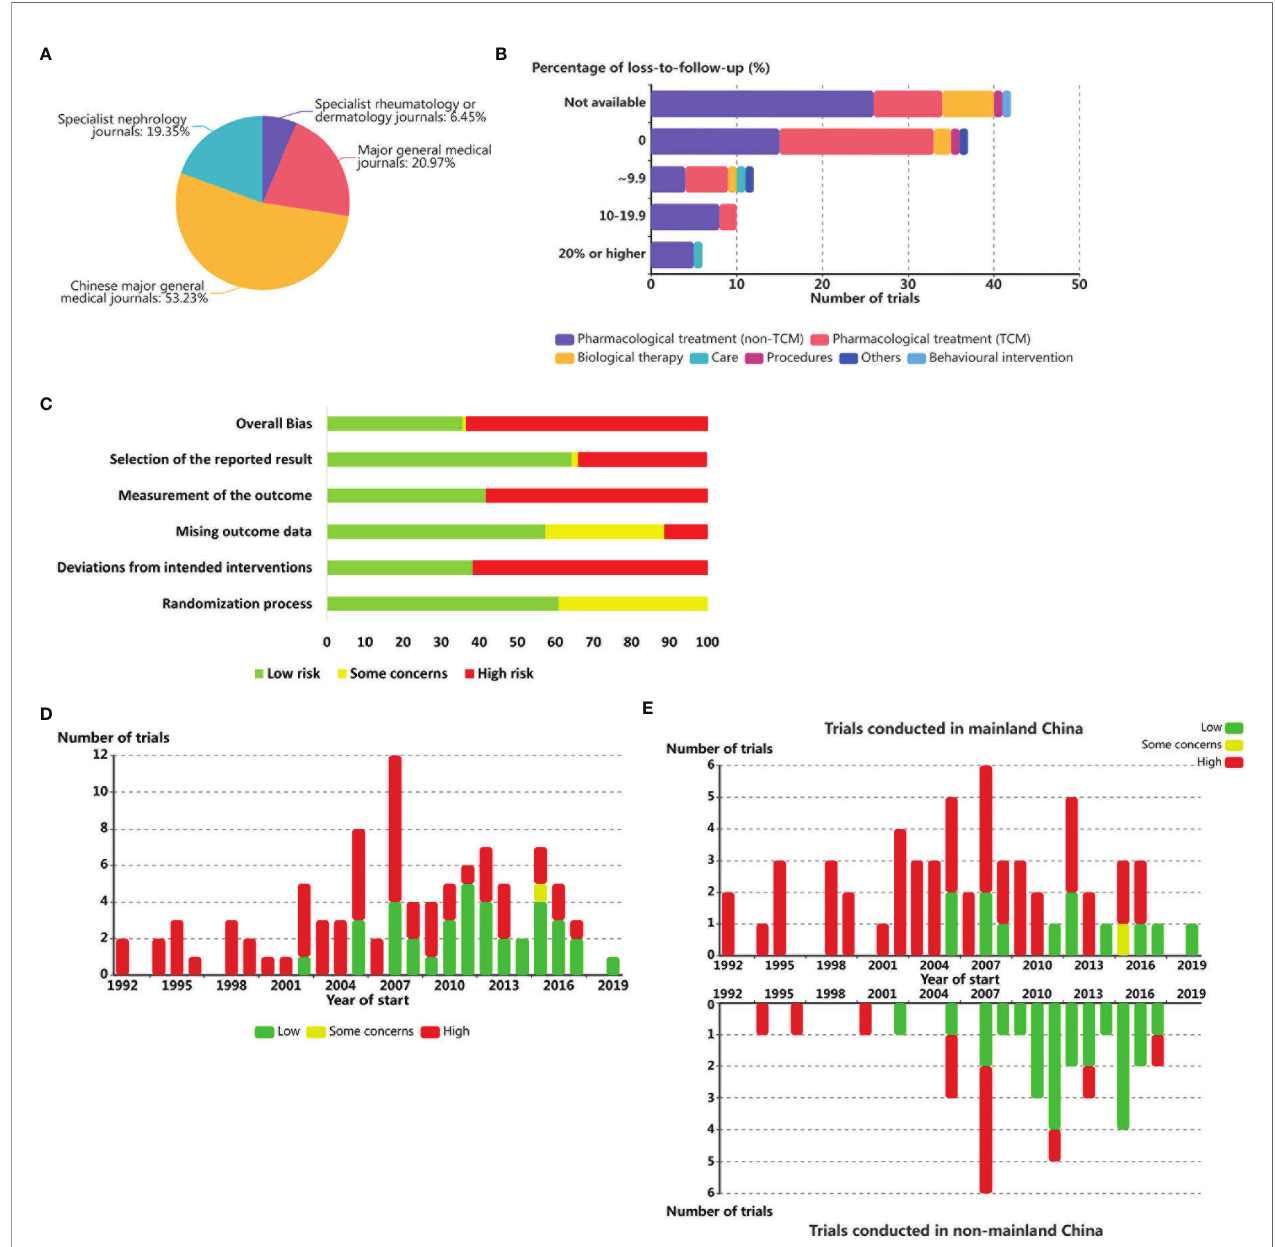
FIGURE 3 | Intervention duration and percentage of loss-to-follow-up among LE RCTs worldwide. (A) Number of published SLE RCTs by journal categories. (B) Number of SLE RCT by intervention categories and percentage of participant loss. (C) Risk of bias summary (Low, some concerns, and high). Each risk of bias item is shown as percentages across all included studies. (D) Number of SLE RCTs by year of start and overall risk of bias. (E) Number of SLE RCTs conducted in mainland China (above) or non-mainland China (below) by year of start and overall risk of